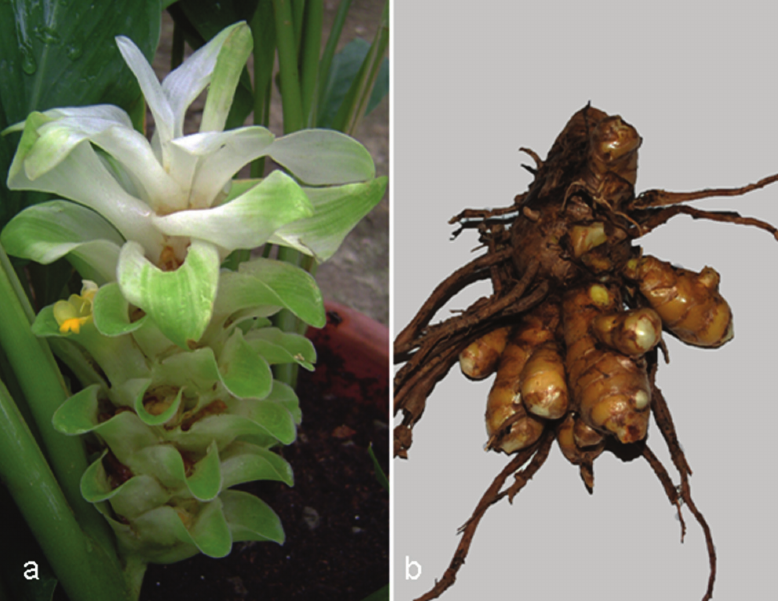
Figure 7. Curcuma longa L.: aerial parts (a) and rhizome (b).